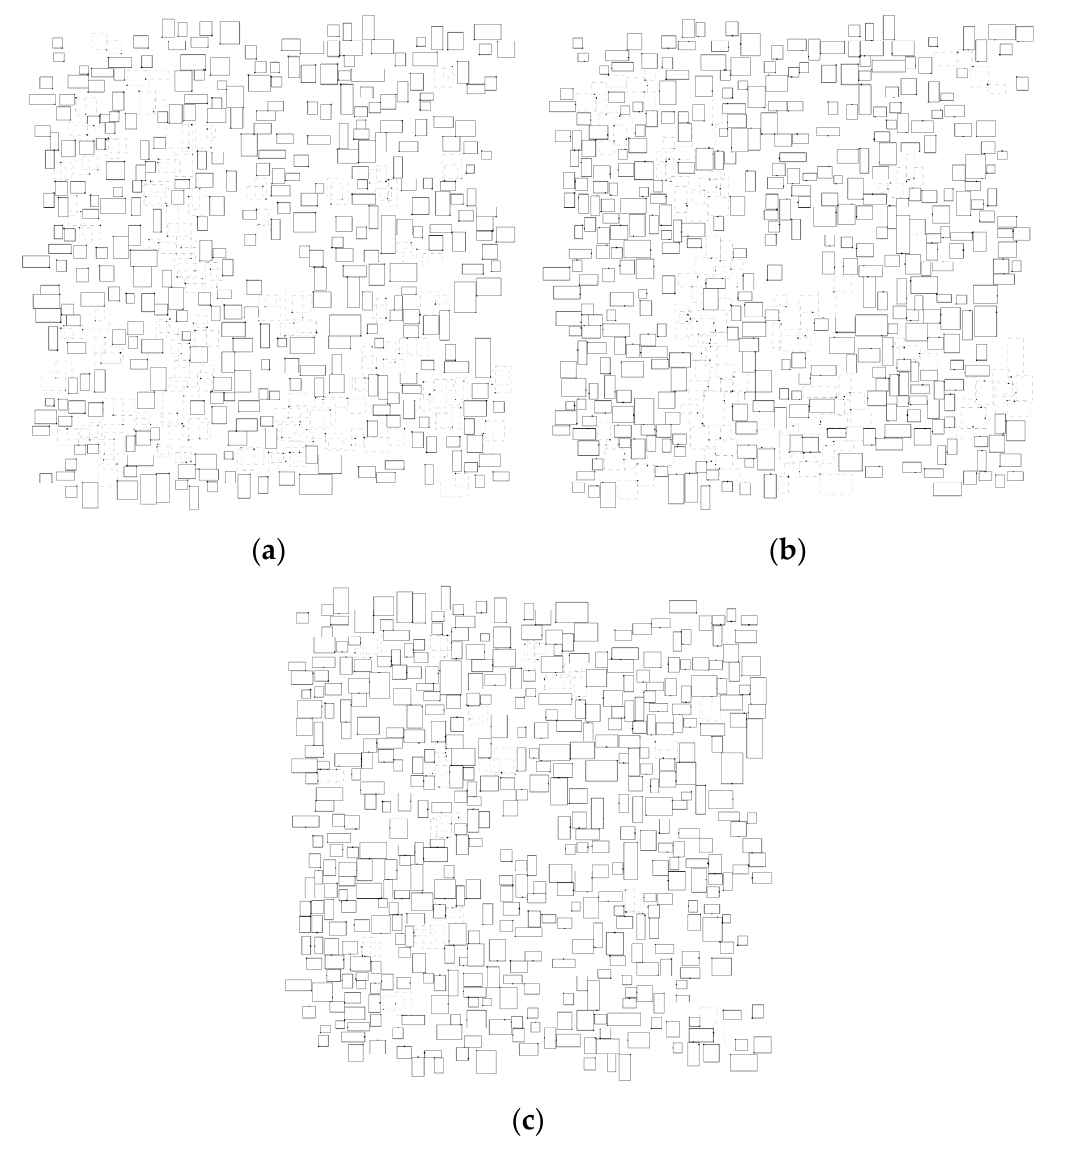
Figure 10. Labeling result for the RandomRect instance with 500 points. ( a ) Four-position model: 339 conflict-free labels; ( b ) four-slider model: 380 conflict-free labels; ( c ) the proposed model: 450 conflict-free